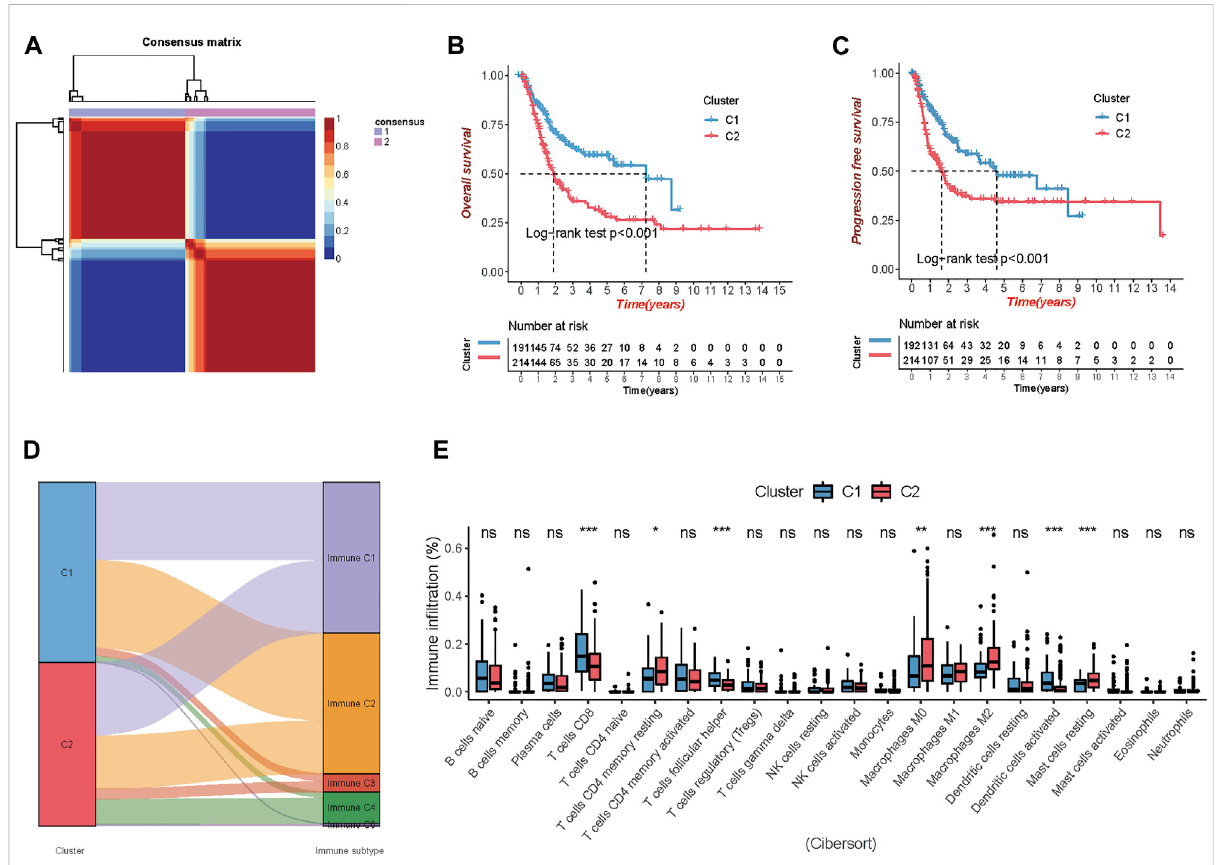
FIGURE 1 Comparison of the two clusters 1 and 2 (C1 and C2) in TCGA-BLCA cohort. (A) Consensus map clustered via the non-negative matrix factorization (NMF) algorithm. (B,C) Overall survival (OS) and progression-free survival (PFS) showed signi fi cant differences. (D) Percentage of the immune subtypes accounting for each of the two clusters. (E) The fraction of tumor-in fi ltrating immune cells in the two clusters using the CIBERSORT algorithm (* p < 0.05; ** p < 0.01; *** p <